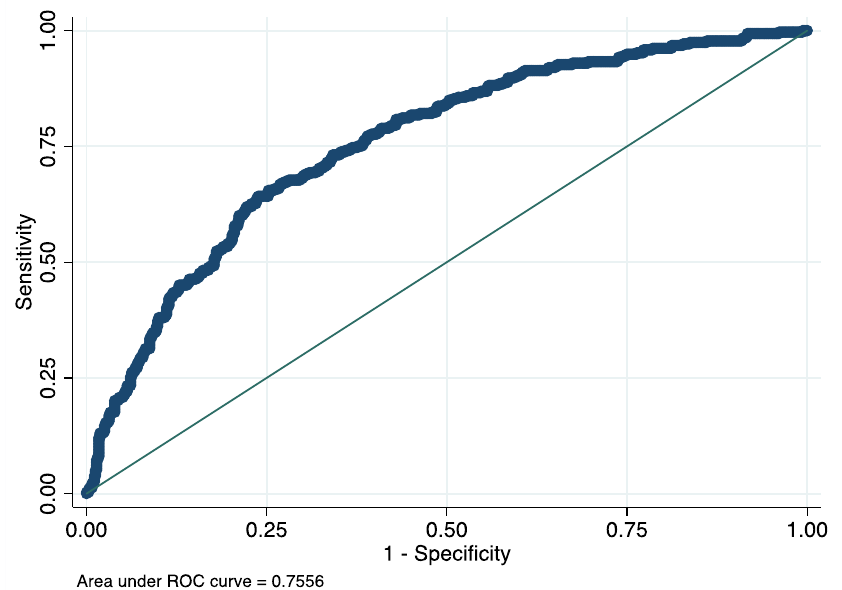
Figure 2. ROC curve of the proposed model showing the discriminant capacity of these variables for distinguishing between patients with COVID-19 from other viral respiratory diseases (AUC = 0.75, p value = 0.001). Table 3. Logistic regression model with dependent variable PCR test results for COVID-19 and using clinical and inflammatory determinations as important predictors for discriminating between patients with COVID-19 and others respiratory complications.